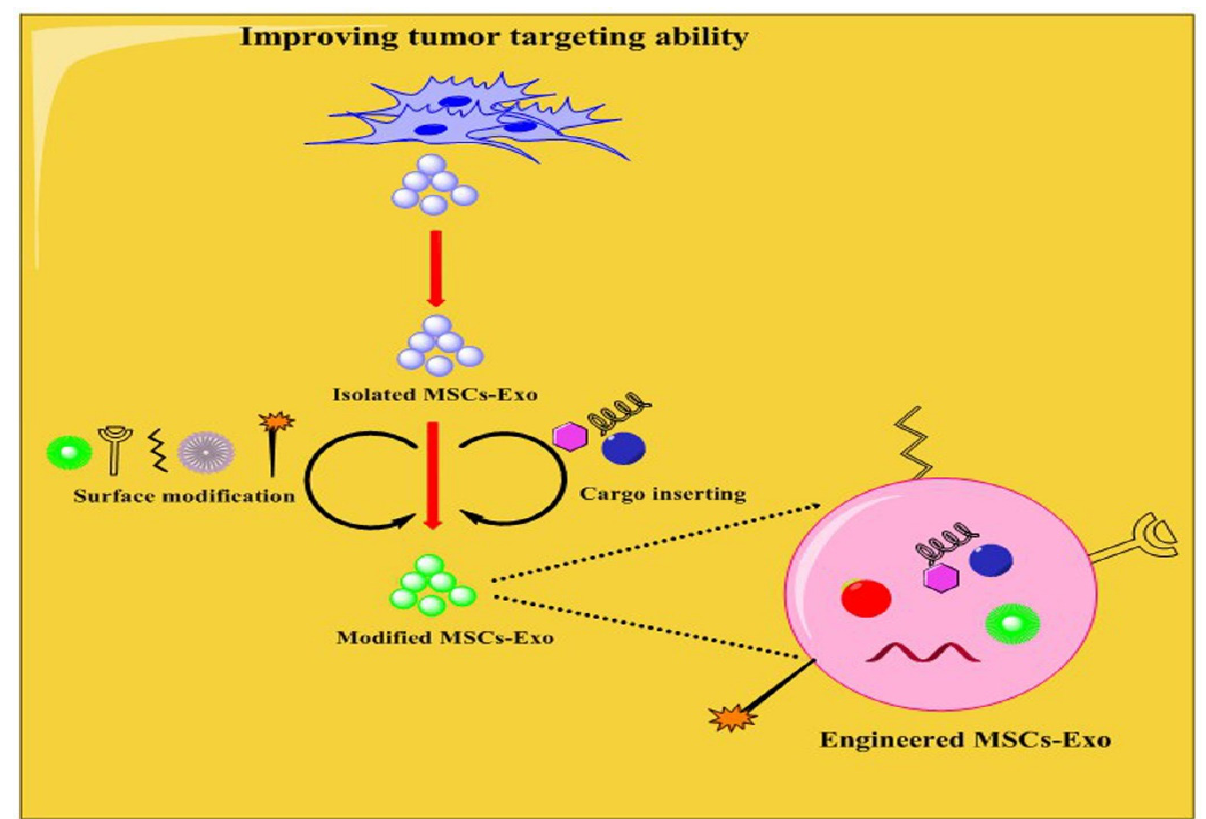
Figure 5. Improving the tumor-targeting ability of exosomes from MSCs (MSCs-Exo). In this theme, MSCs-Exo are modified in their content and surface to increase therapeutic efficiency. Molecules such as galectin-9 siRNA, hyaluronic acid, folate receptor, erastin, and metalloproteinases (MMPs) are used to engineer MSCs-Exo. These exosomes can be named engineered exosomes which can smartly deliver the therapeutic agent to tumor cells.